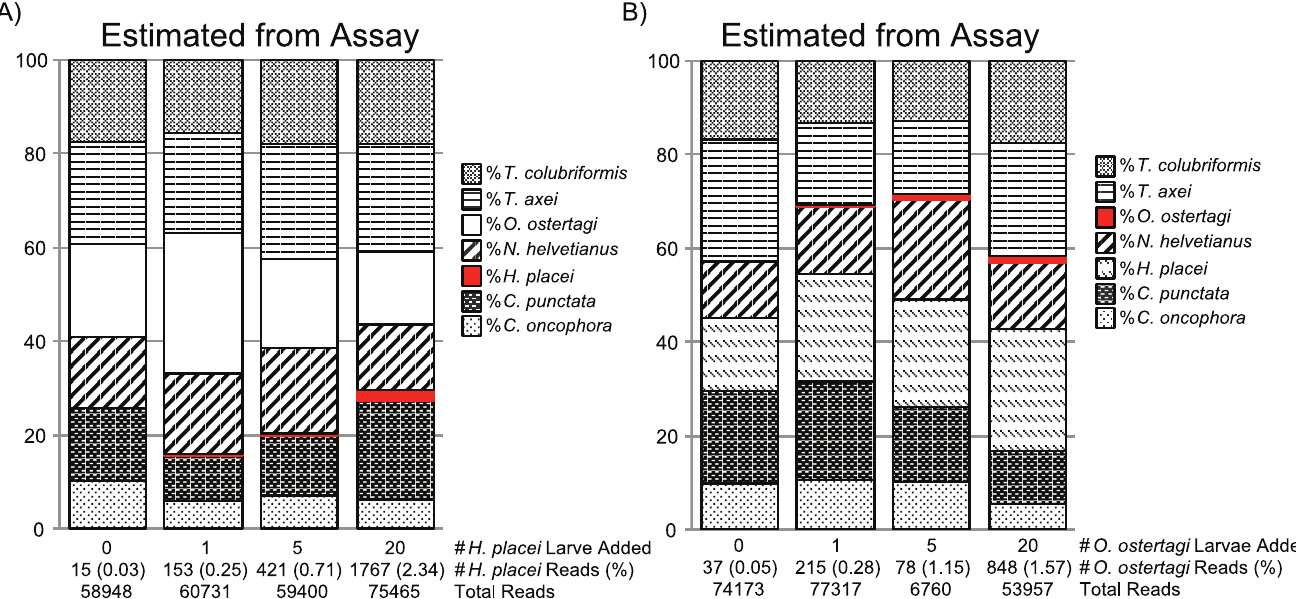
Fig 4. Detection threshold of the amplicon sequencing assay. Separate mock pools of ~2000 larvae were created consisting of equal proportions of 6 parasite species. The seventh species was then added in increasing numbers of 0, 1, 5 and 20 larvae respectively. The charts show the species proportions estimated from the results of the amplicon sequencing assay (following application of the appropriate correction factor). In each case, the Y-axis shows the percentage proportions of each species and the X-axis indicates the number of H . placei or O . ostertagi larvae added as well as the numbers of reads assigned to H . placei and O . ostertagi for Fig 4A and 4B respectively. Fig 4A . Results when H . placei was added in increasing numbers to a pool comprising an equal number of N . helvetianus , C . oncophora , T . axei , T . colubriformis , C . punctata and O . ostertagi . Fig 4B . Results when O . ostertagi was added in increasing numbers to a pool comprising an equal number of shows N . helvetianus , C . oncophora , T . axei , C . punctata , T . colubriformis and H . placei